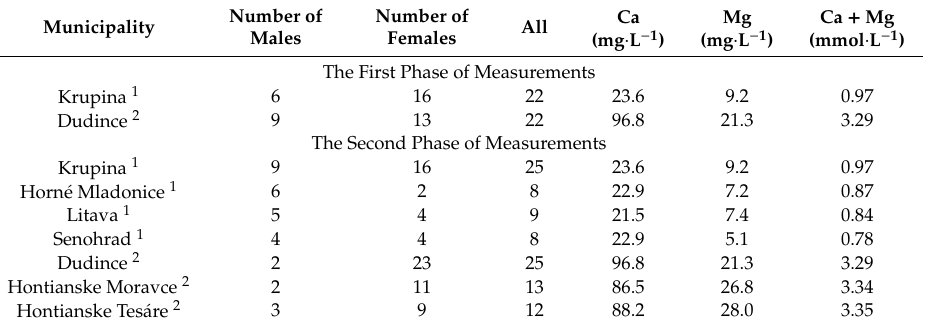
Table 1. Summary of participants involved in the measurements of arterial sti ff ness and chemical composition of drinking water in terms of Ca and Mg contents.